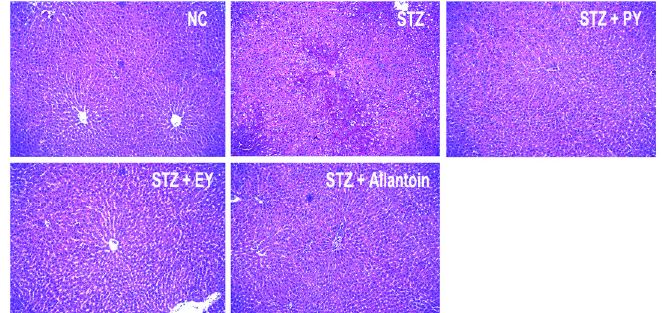
Figure 7. Microphotographs of hepatic tissues (H ‐ E staining, 100×). NC, normal control; STZ, diabetic control; STZ + PY, crude yam powder ‐ treated diabetic; STZ + EY, water extract of yam ‐ treated diabetic; STZ + Allantoin, allatoin ‐ treated diabetic rats.